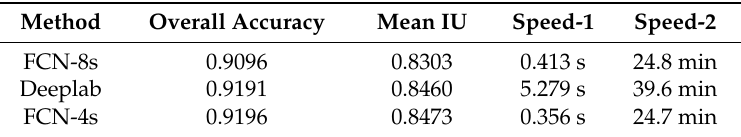
Table 3. Experimental results on different semantic labeling approaches. Speed-1 was measured using the inference time for a single imagery (1000 × 1000 pixels), and speed-2 was measured using the total time required to generate the weed cover map for the whole field, including data collection and data processing. FCN—fully convolutional networks.